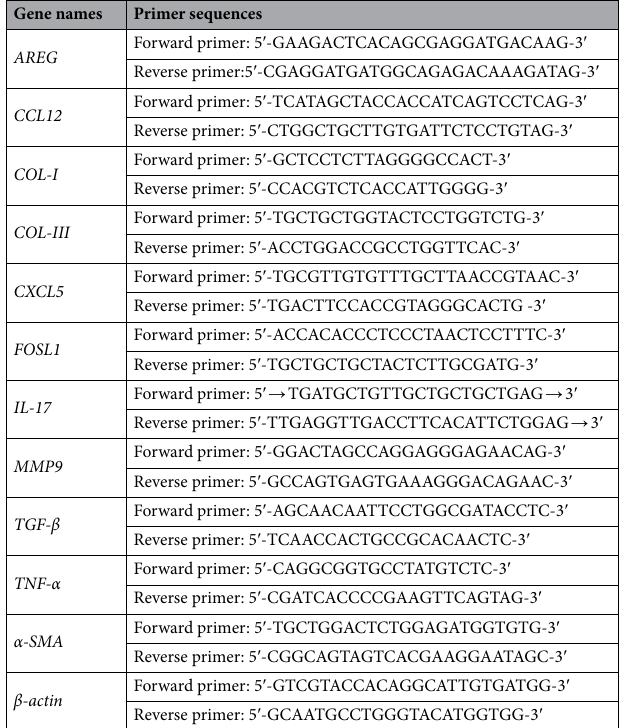
Table 2. Sequences of qRT-PCR